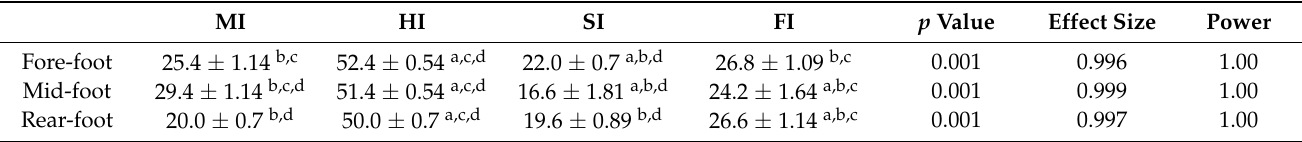
Table 2. Hardness of four insoles